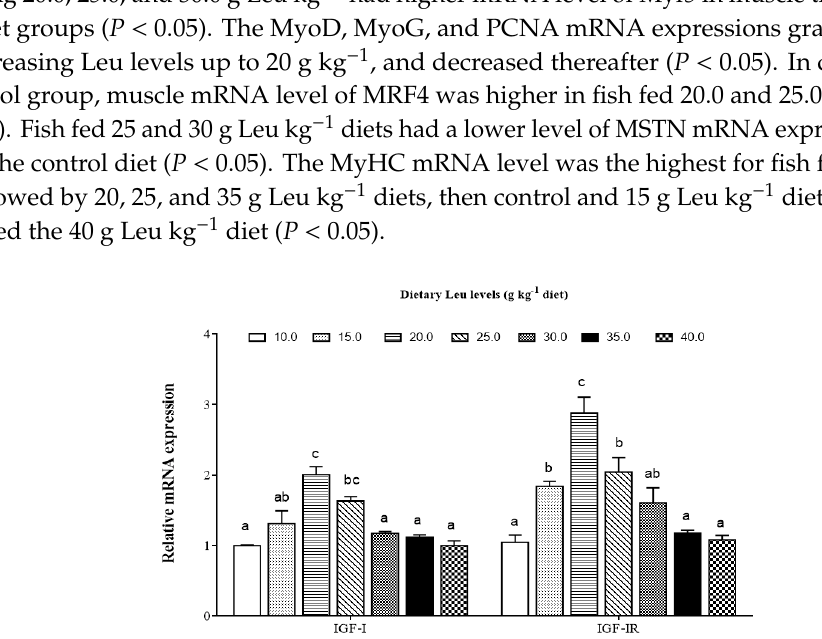
Figure 3. Effect of dietary Leu on protein content (mg protein ∙ g tissue − 1 ( A )) and RNA/protein ratio (mg RNA ∙ g protein − 1 ( B )) in hybrid catfish muscle. Data represent means ± SEM of three replicates, with six fish in each replicate. Values having different letters are significantly different ( P < 0.05).